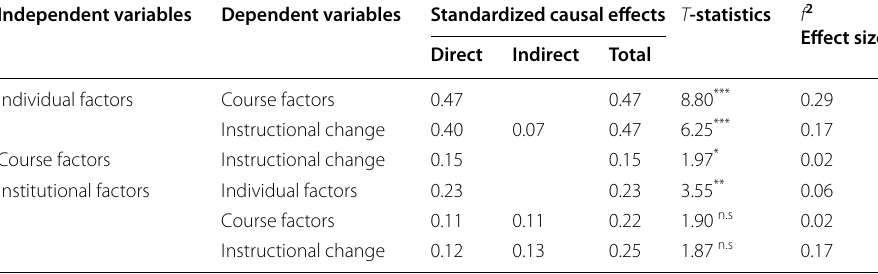
Table 3 Results of structural model assessment